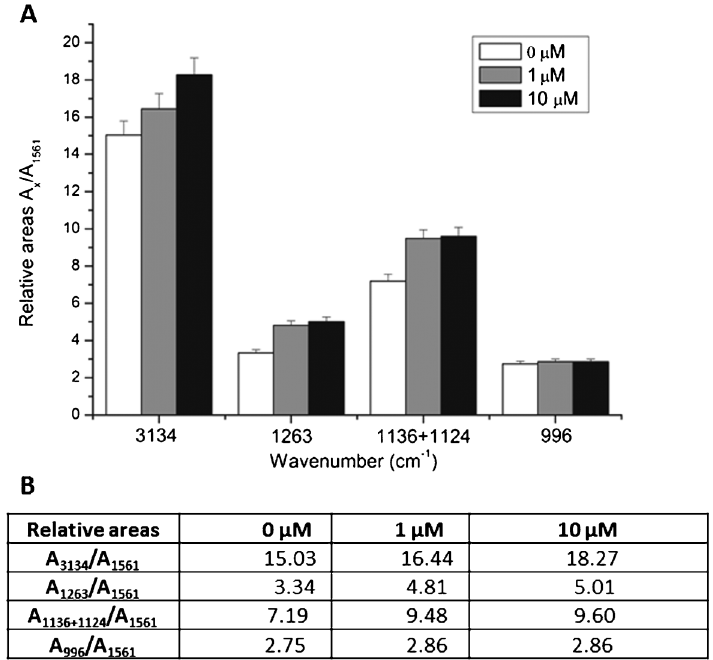
Figure 6. Nucleic acid vibrational state. A , Ratio of the integrated areas of absorption between nucleic acids and amide II band at 1561 cm -1 after H9c2 were incubated with 0, 1, and 10 m M celecoxib for 24 h. B , Relative areas of nucleic acid bands of H9c2 after incubation with celecoxib for 24